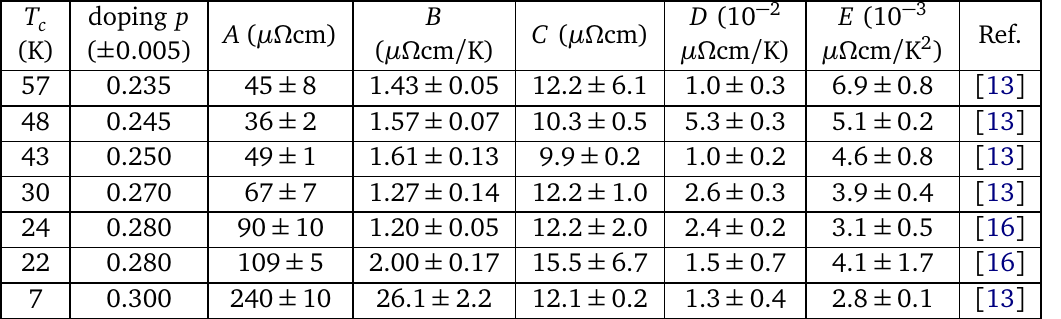
Table 1: Fitting parameters of the zero-field resistivities in the parallel conductivity channel scenario for Tl2201 [ 13,16 ] . The parameters A , B , C , D and E are described in Eq. (20) and (21). The error bars indicate the standard deviation extracted from the fitting procedure. All parameters are also subject to an additional 20 % error resulting from the uncertainty in sample geometry that is not included here but is incorporated into the error analysis in Fig.